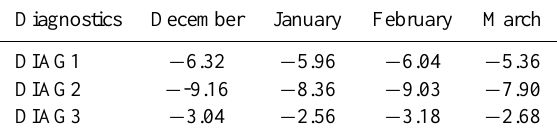
Table 3. Percentage mean change in DIAG1, DIAG2, DIAG3 for belt.